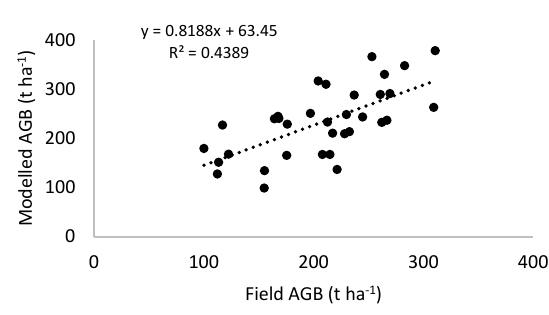
Figure 8: - Linear regression between modelled biomass (y axis) and field biomass (x axis) for the 34